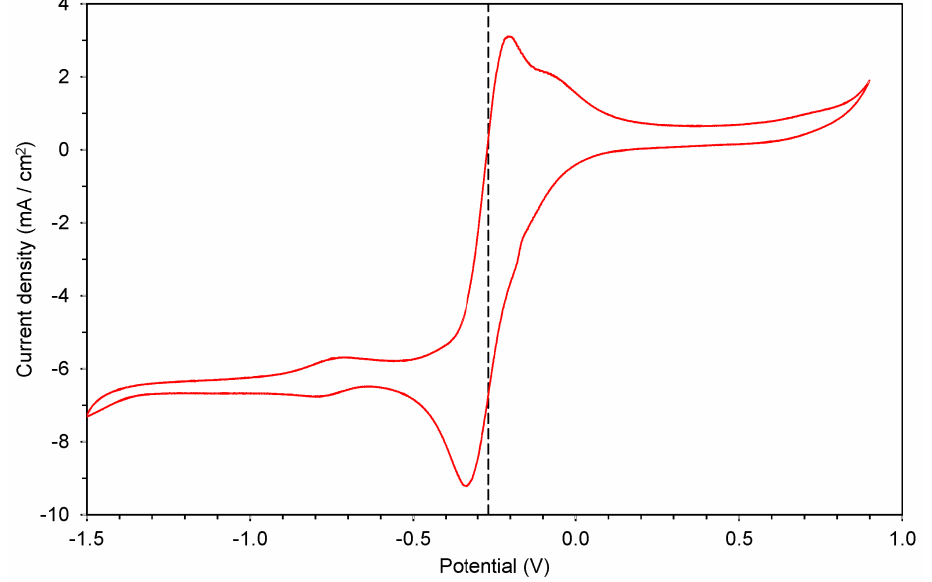
Figure 6. Cyclic voltammogram of 2 (0.02 M in CH 3 CN) on a gold electrode vs.